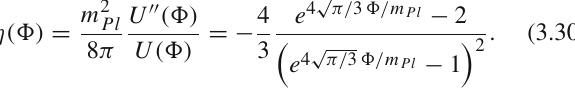
The slow-roll parameters